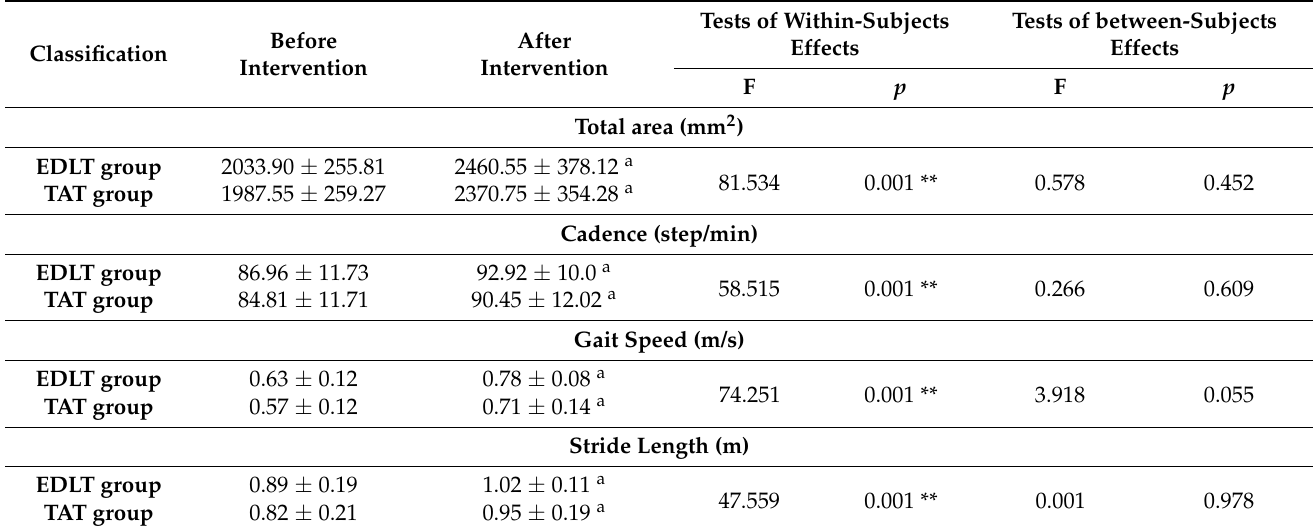
Table 2. Two-way repeated measure analysis results of limited of stability and gait